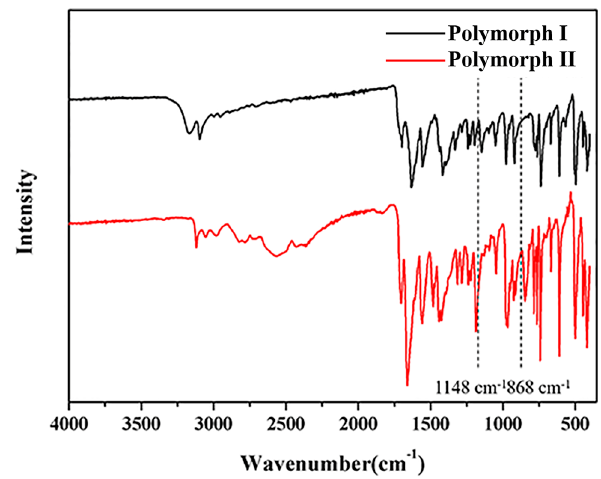
Figure 5. FTIR spectra of polymorph I and polymorph II of theophylline.